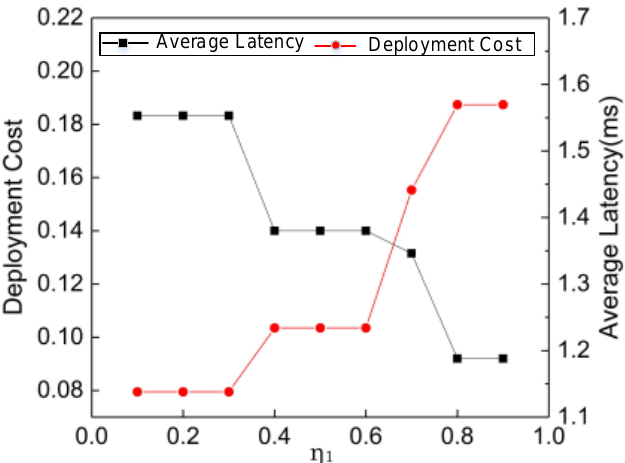
Figure 10. Impact of η 1 on deployment cost and average latency.